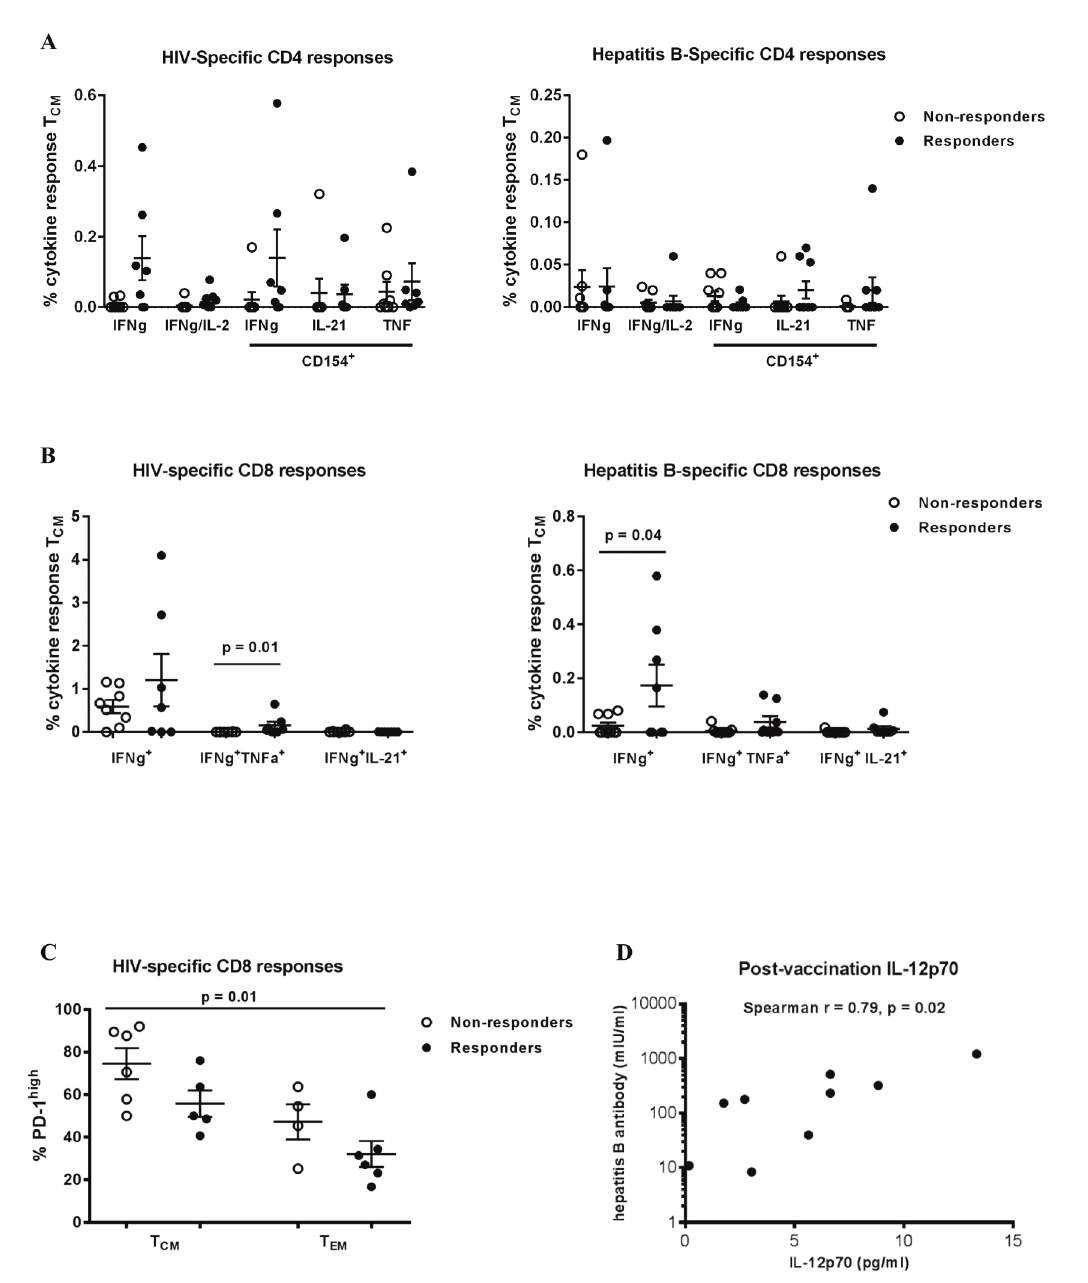
Figure 4. Preserved Th1 adaptive immunity in HBV vaccine responders. (A) Pooled data showing the relative frequencies of antigen-specific CD4 T cell responses measured by intracellular cytokine staining (ICS) after short ex vivo stimulation with HIV Gag ( left panel ) or hepatitis B surface antigen peptides ( right panel ), (B) Pooled data showing the relative frequencies of antigen-specific CD8 T cell responses mea- sured with ICS, (C) expression of PD-1 in HIV-specific CD8 T cells in non-responders and responders ( P = 0.001, Kruskal-Wallis test), (D) Correlation between plasma IL-12p70 levels and HbSAb titer. Data presented are scatterplots with mean and SEM with P -values calculated using the Mann-Whitney U test (B) or Spearman correlation test